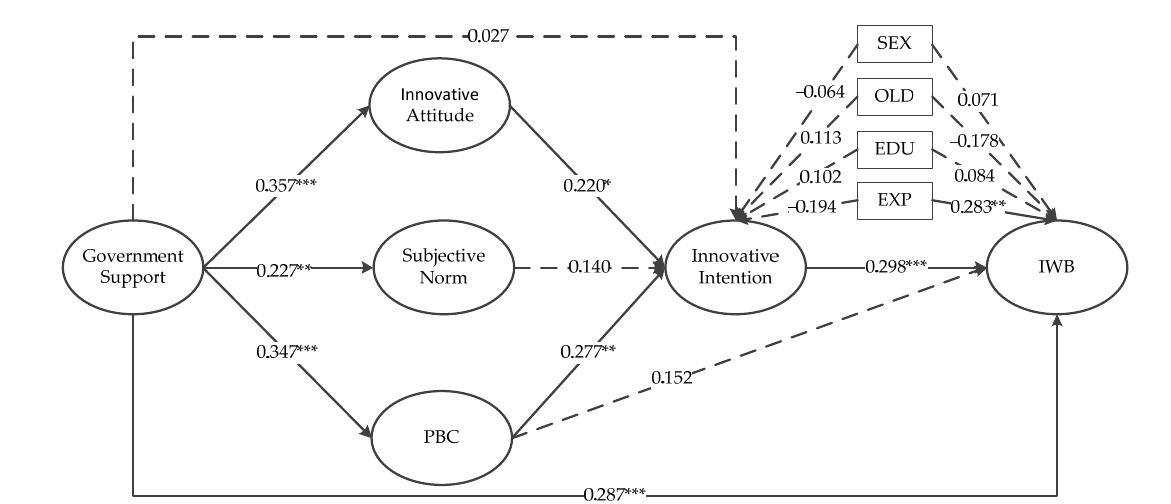
Figure 2. Path coefficients for the final structural model. * p < 0.10; ** p < 0.05; *** p < 0.01. Solid arrows indicated the significant paths. Dotted arrows indicated the insignificant paths.